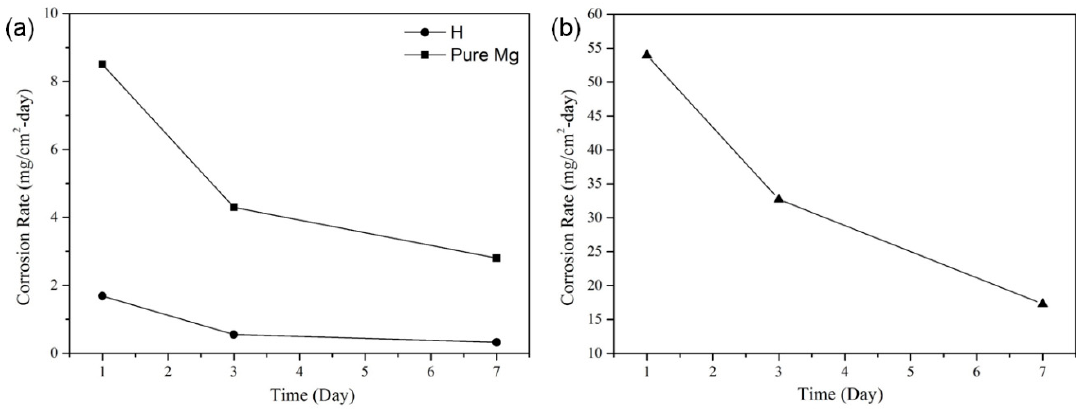
Figure 15. Corrosion rate in immersion test ( a ) XK105-H and pure Mg and ( b ) surface-roughened XK105-H.